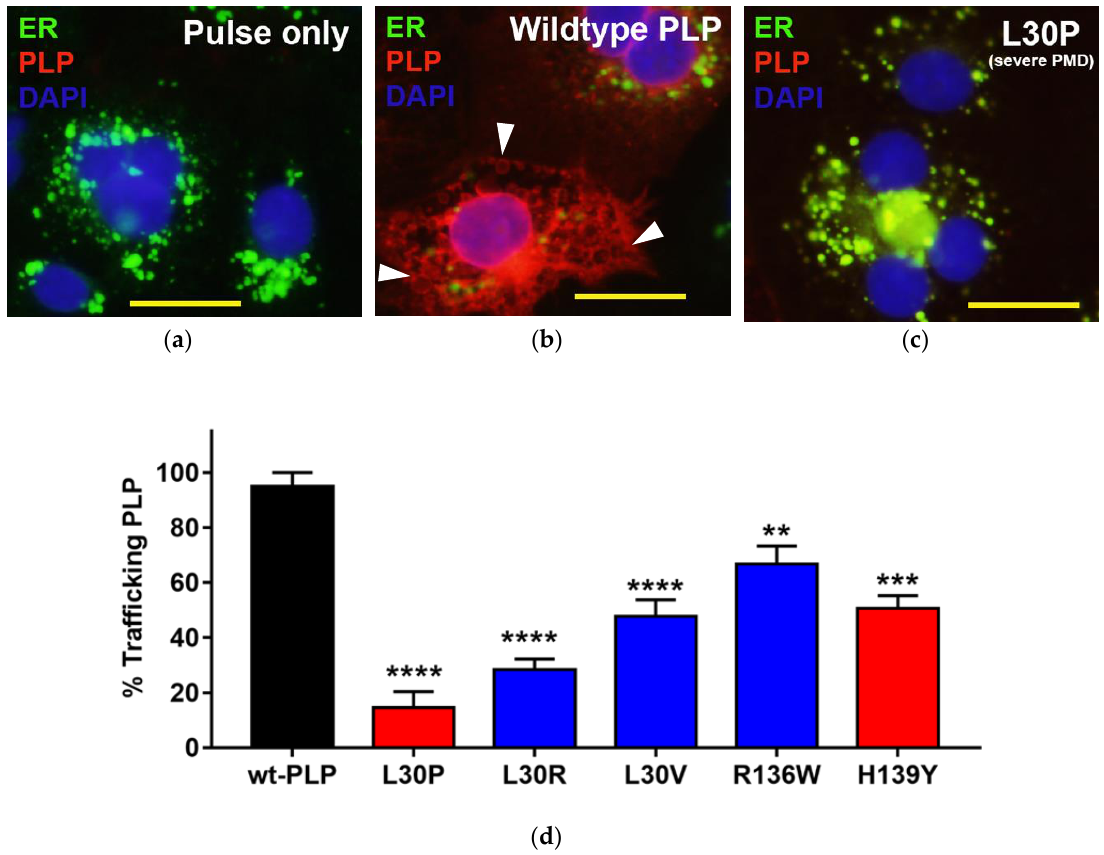
Figure 3. Mutations at L30 cause PLP to be retained within the endoplasmic reticulum (ER). ( a ) Cells transfected with empty vector show labelling with the ER-ID stain (green), but no labelling for PLP, as expected. ( b ) After 24 h of culture of cells transfected with the wild-type (wt)-PLP vector, mCherry- tagged PLP (red) trafficked out of the ER. ( c ) In contrast, almost all PLP was retained within the ER (indicated by co-localisation of PLP and ER labelling) in cells transfected with the L30P mutant. Blue = 4 ′ ,6-diamidino-2-phenylindole (DAPI), red = mCherry-tagged PLP, and green = ER-ID stain. (Size bar = 50 µm). ( d ) Summary of the percentage of cells expressing the different PLP1 mutations that can traffic PLP out of the ER. The bars show mean ± SE of at least 20 cells analyzed for each group, and are color- coded as in Figure 2b. ** p < 0.01, *** p < 0.001, **** p < 0.0001.